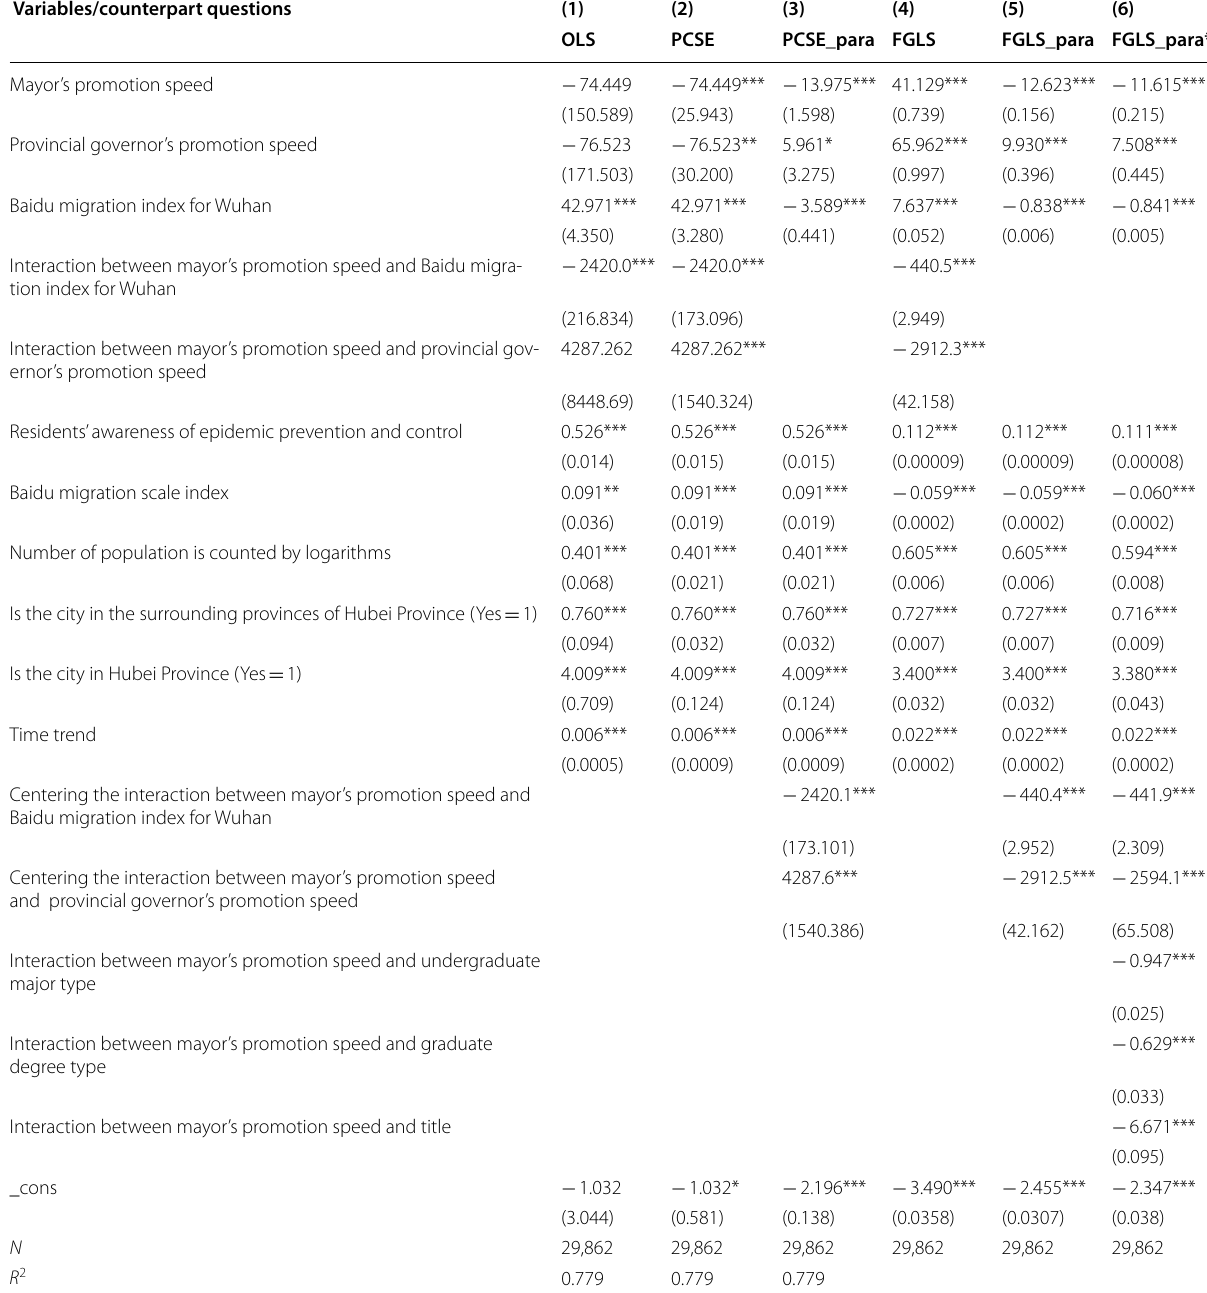
Table 3 The official promotion speed and the pandemic prevention and control